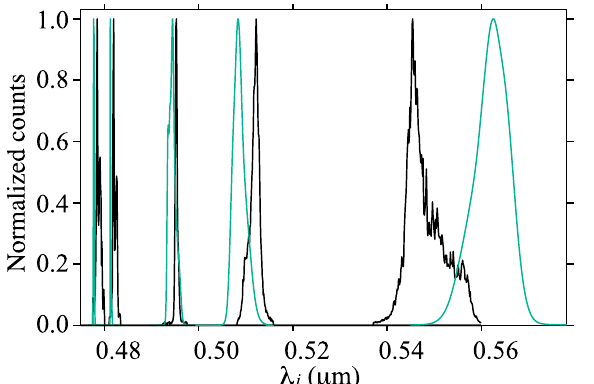
Figure 5. Comparison between normalized experimental (black) and numerically-simulated spectra (green) for (cid:31) p = 0.741 µ m .